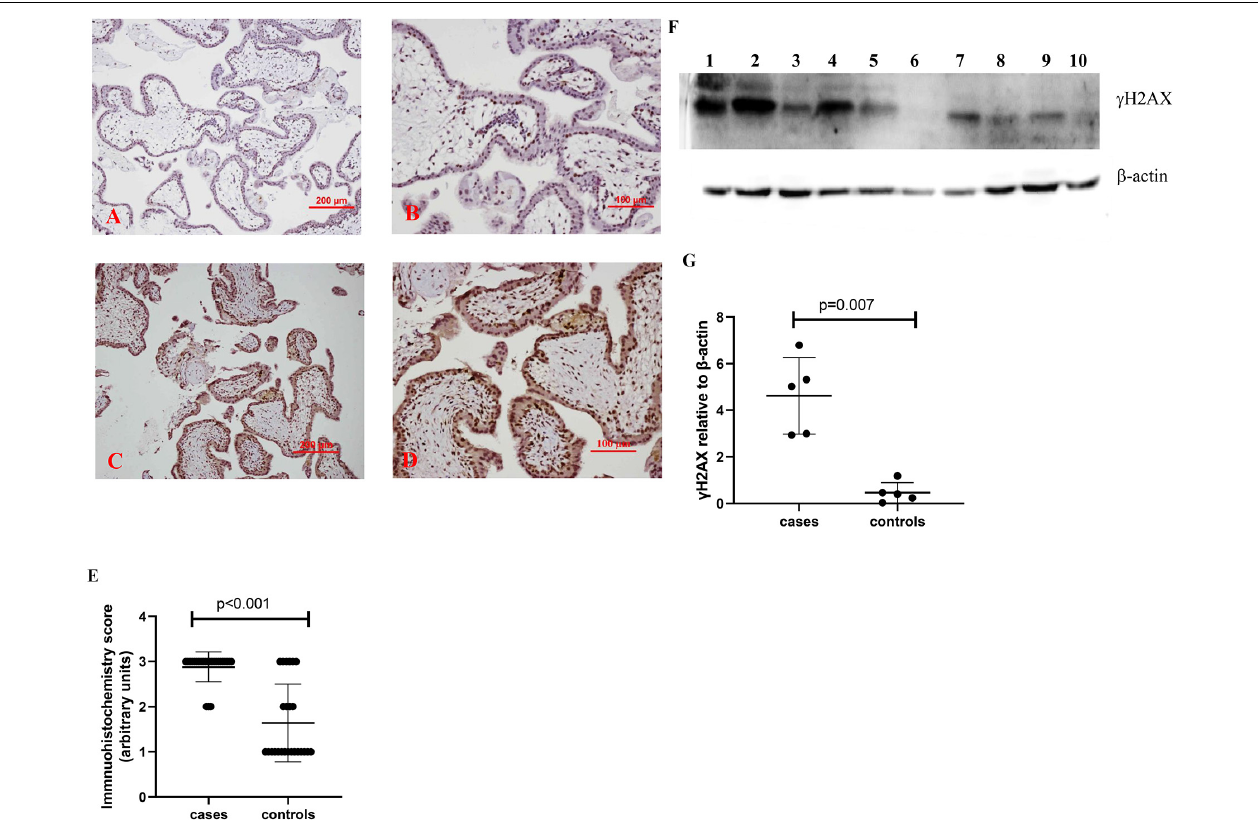
FIGURE 3 | Representative immunohistochemical staining showing that the γ H2AX was increased in missed miscarriage placentas [ (C) low magnification, D: high magnification] compared to healthy first-trimester placentas [ (A) low magnification, B: high magnification]. Semiquantitative analysis of the immunohistochemistry images showing a significantly increased expression of γ H2AX in placentas from missed miscarriage (E) . Representative Western blot (F) demonstrating that the levels of γ H2AX were significantly increased in missed miscarriage placentas (lanes 1–5) compared to controls (lanes 6–10), measured by a semiquantitative analysis (G)